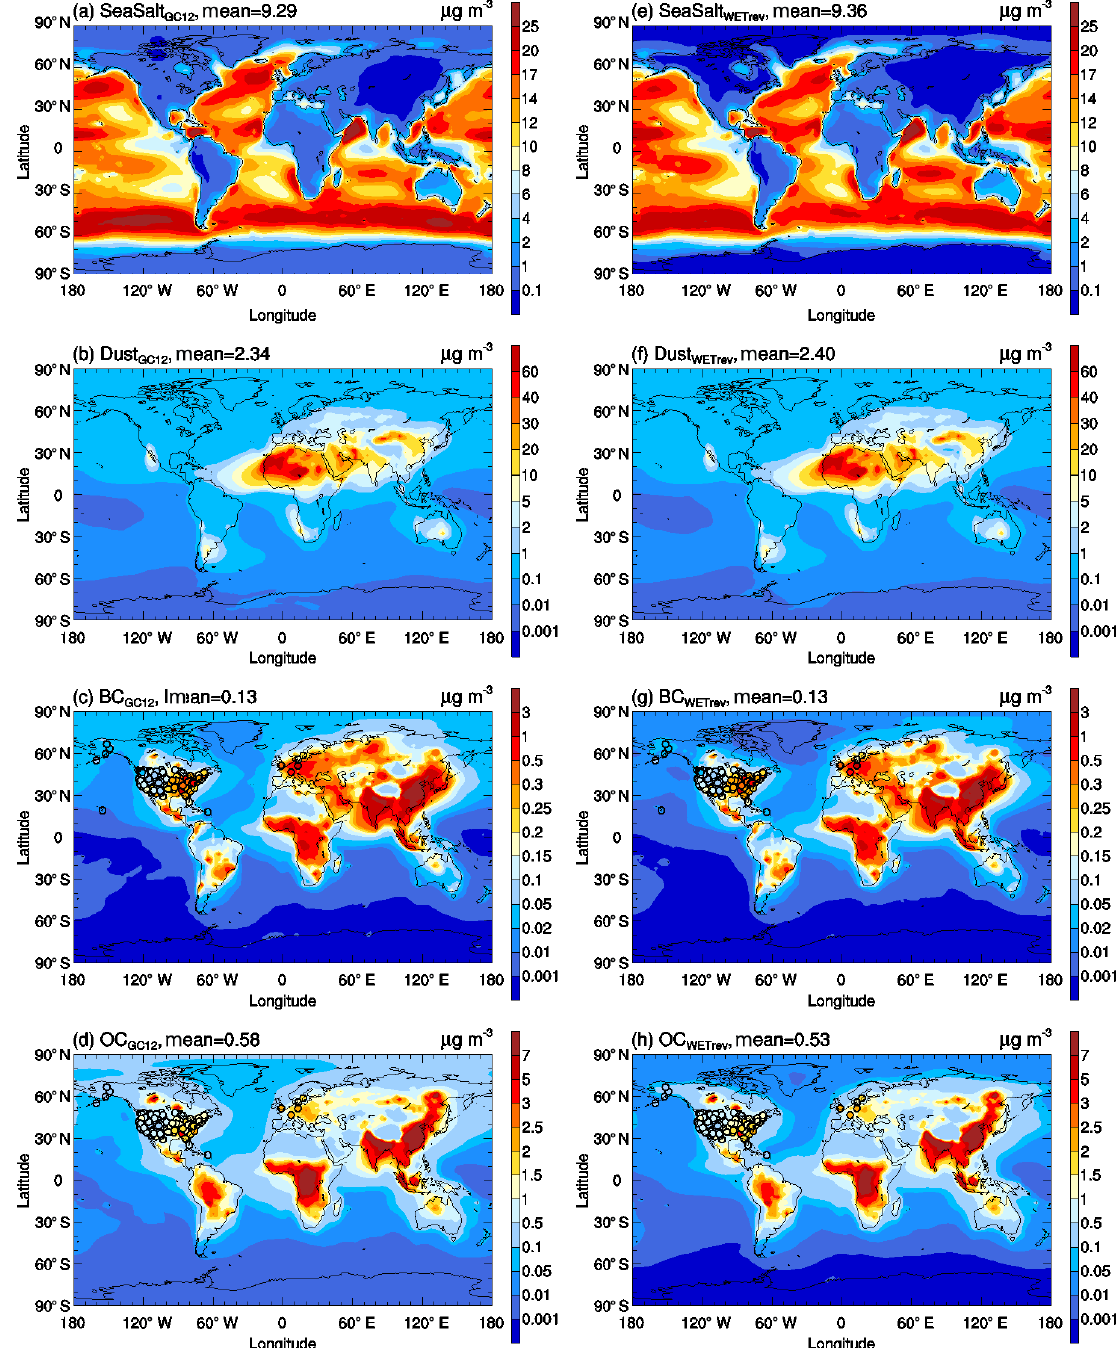
Figure 12. The same as Fig. 10 but for black carbon, organic carbon, sea salt, and dust surface mass concentrations.